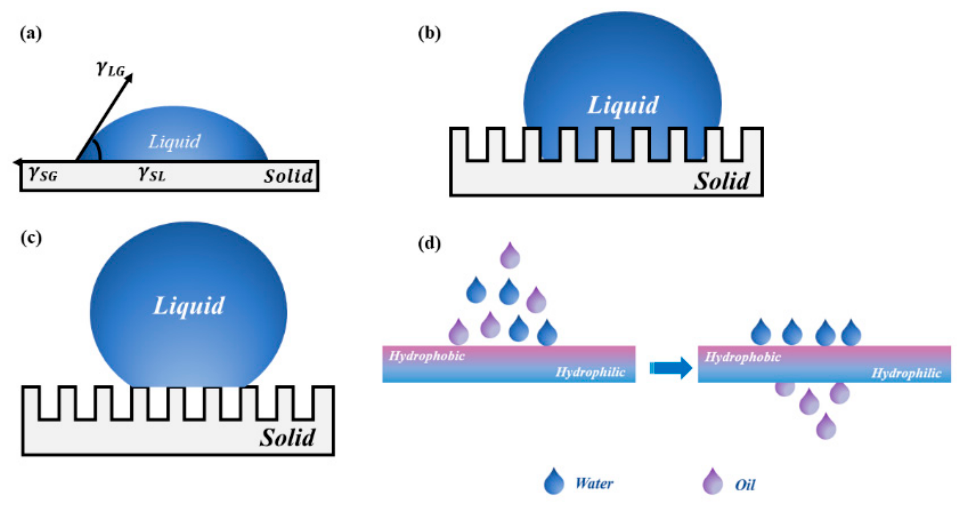
Figure 2. The liquid transmission mechanism: ( a ) Young’s model; ( b ) Wenzel model; ( c ) Cassie–Baxter model; ( d ) schematic diagram of liquid transmission of asymmetric wettable Janus materi- al.